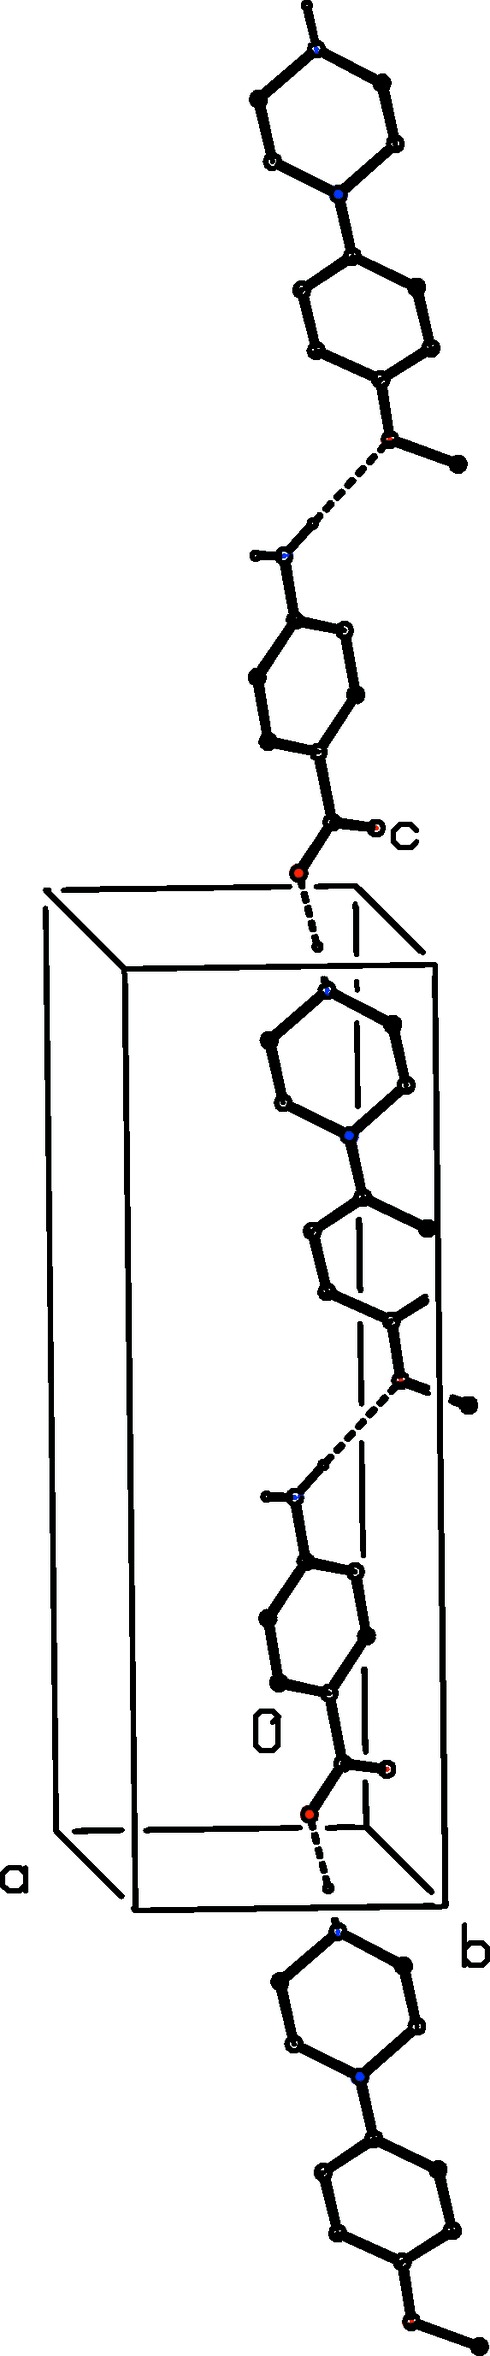
Part of the crystal structure of compound (IV) showing the formation of a hydrogen-bonded chain parallel to [001]. Hydrogen bonds are drawn as dashed lines and, for the sake of clarity, the water mol­ecules and the H atoms bonded to C atoms have been omitted.